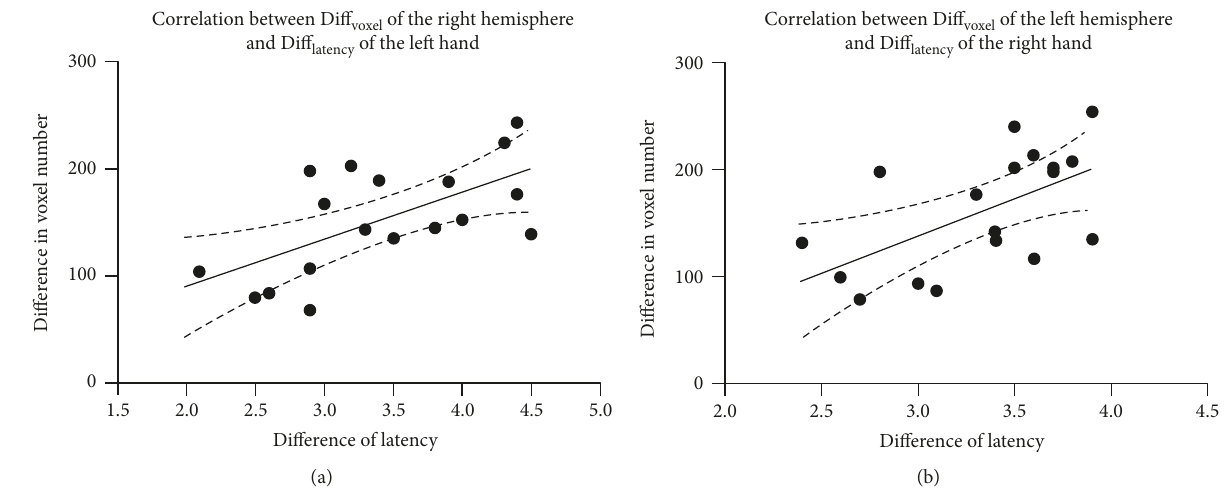
Figure 3: Results of the correlation analysis between fMRI measurement and clinical assessment. (a) The post-presurgery di ff erence of activated voxels in the right postcentral gyrus is positively correlated with the post-presurgery improvement of sensory latency of the left- wrist median nerve. The R square is 0.39. (b) The post-presurgery di ff erence of activated voxels in the left postcentral gyrus is also positively correlated with the post-presurgery improvement of sensory latency of the right-wrist median nerve. The R square is